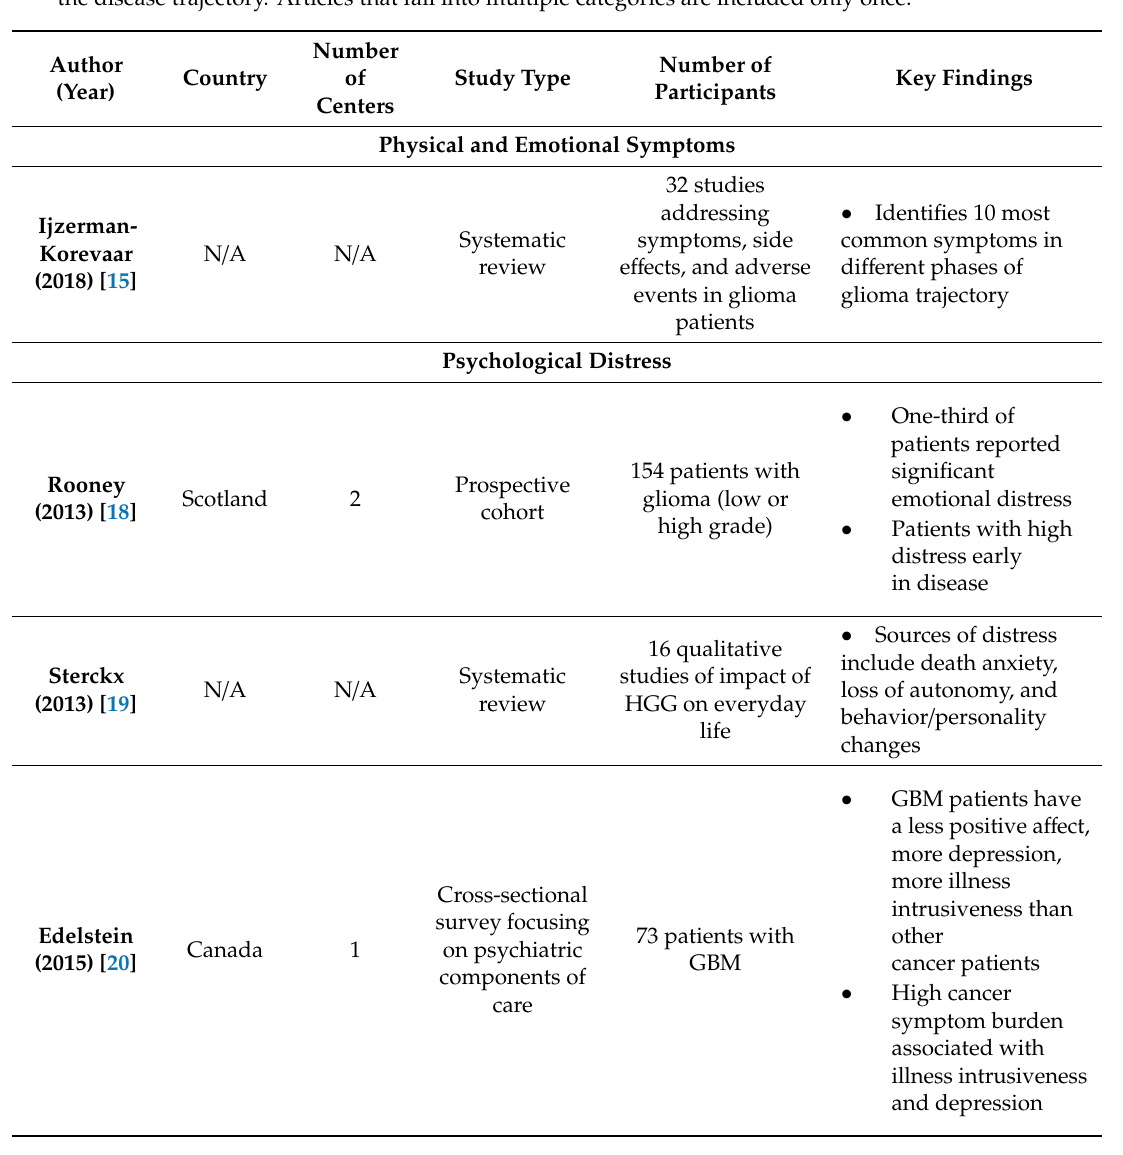
Table 1. Summary of the literature on the supportive care needs of patients with HGG throughout the disease trajectory. Articles that fall into multiple categories are included only